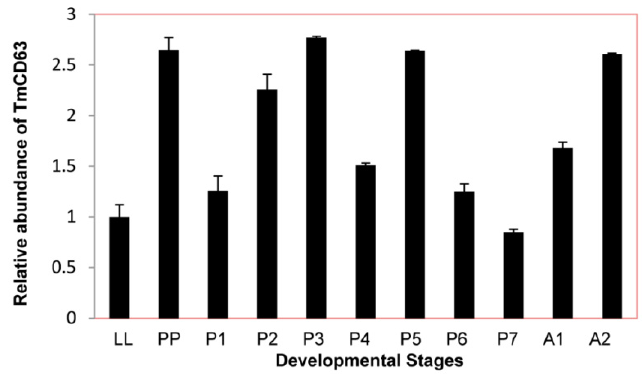
Figure 7. Developmental expression patterns of TmCD63 in mealworm beetle T. molitor . Ribosomal protein L27a ( T. molitor ) was used as an internal control to normalize RNA levels between samples. The relative expression was calculated by comparing the cycle threshold value of TmCD63 to L27a. Vertical bars represent standard deviations ( n = 3). The analysis was performed using real-time PCR based on SYBR green. LL: Late larva; PP: Prepupa; P1: Pupa day 1; P2: Pupa day 2; P3: Pupa day 3; P4: Pupa day 4; P5: Pupa day